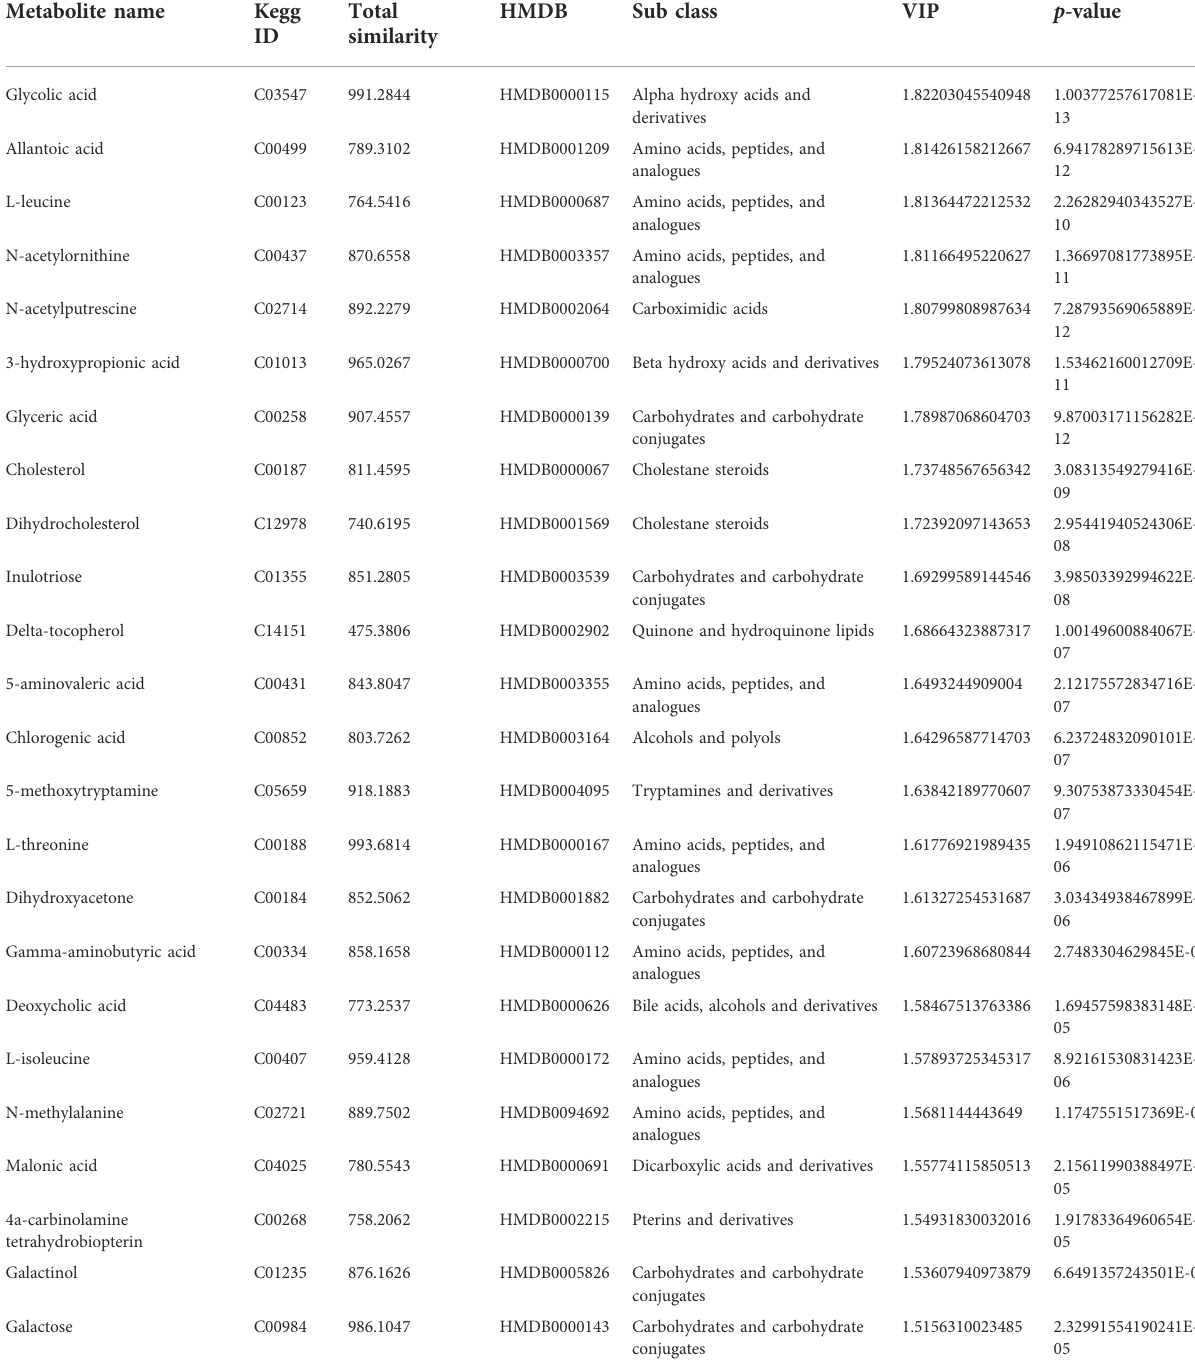
TABLE 2 The differential metabolites in the freezing media for the T and G